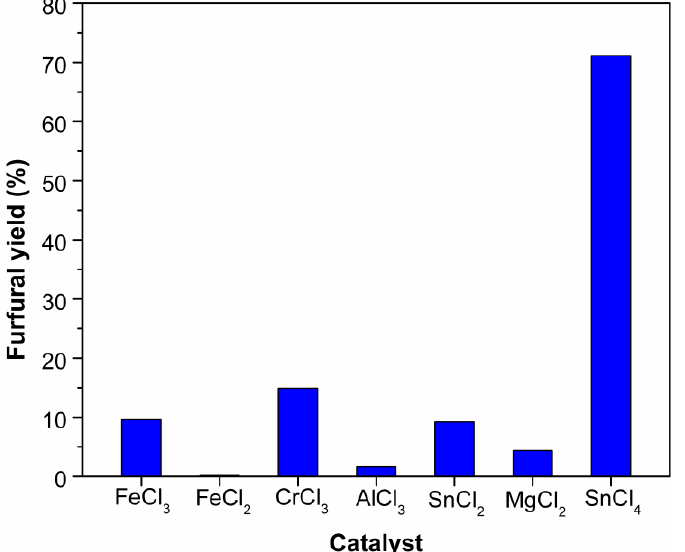
Figure 1. Effect of catalysts on the dehydration of xylose into furfural in EMIMBr. Reaction conditions: 200 mg of xylose was dissolved in 1000 mg of EMIMBr; molar ratio of catalyst:xylose = 1:10; 130 °C; 1 h.